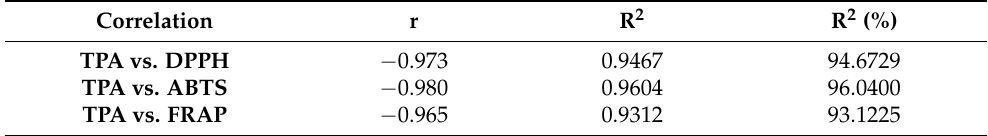
Table 15. Correlation coefficients between TPA and antioxidant methodologies.